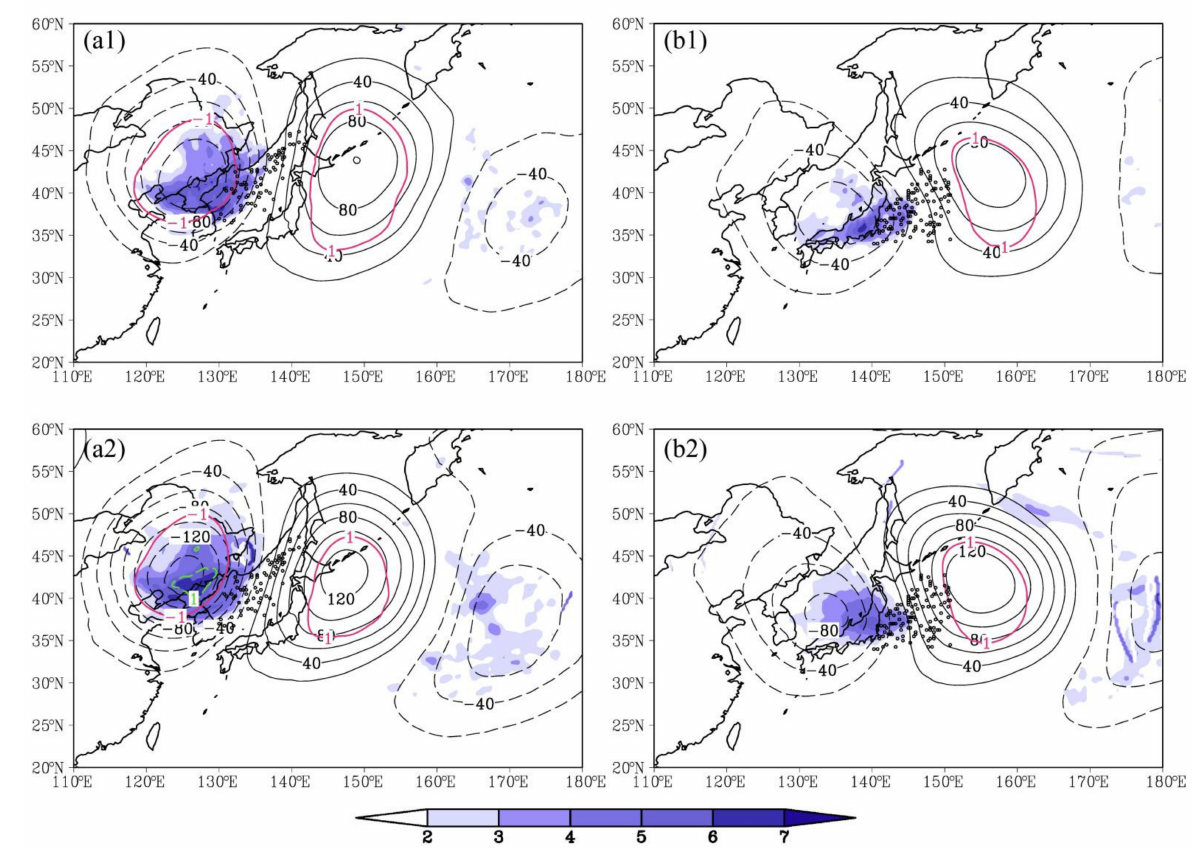
Figure 12. Anomaly fields of composite geopotential height (black line, 20 pgm intervals) and relative vorticity (shaded, 1 × 10 − 5 s − 2 intervals) for ECs at the maximum-deepening-rate moment over ( a1 , a2 ) the Japan Sea and ( b1 , b2 ) Kuroshio/Kuroshio Extension at ( a1 , b1 ) 500 hPa and ( a2 , b2 ) 300 hPa. The red and green lines indicate the RAS of geopotential height and relative vorticity equal to 1 or −